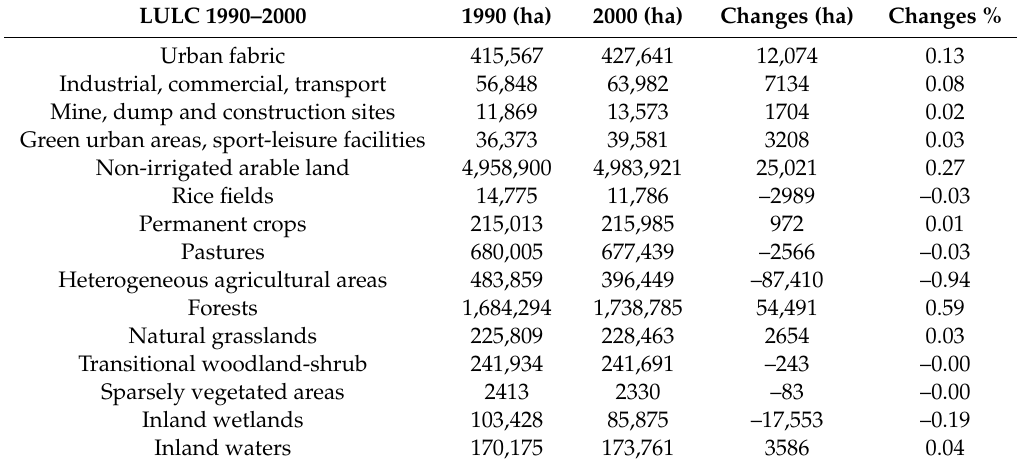
Table A1. Area a ff ected by LULC change in Hungary between 1990 and